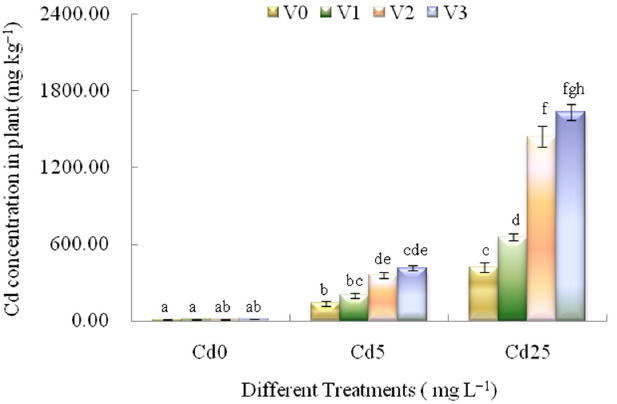
Figure 1. Effects of different EF-Cd treatments on plant Cd concentrations in L. japonica . V0, V1, V2 and V3 showed 0, 1, 2 and 3 V cm − 1 electric fields. Cd0, Cd5, and Cd25 showed 0, 5 and 25 mg L − 1 Cd treatments. Different letters indicate significant differences at the p < 0.05 level. Values represent mean ± SD.